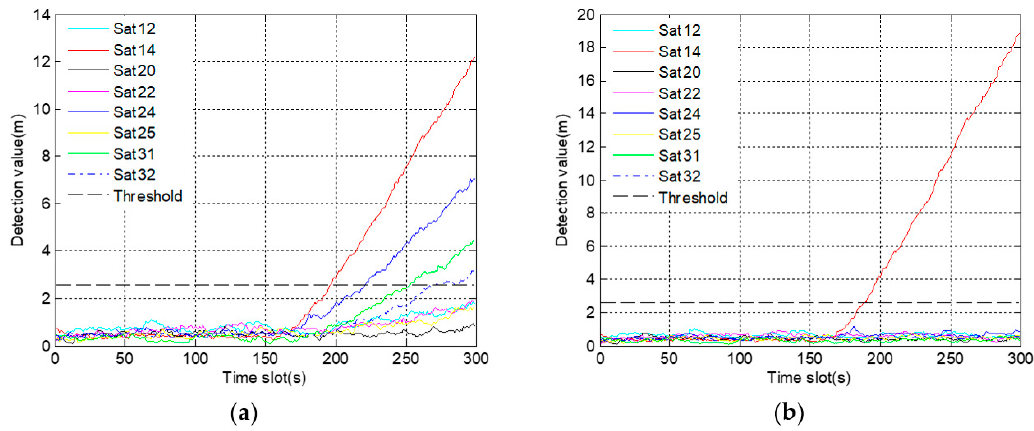
Figure 9. The graph of fault identification statistics corresponding to gradual fault: ( a ) before using a robust algorithm; ( b ) after using a robust